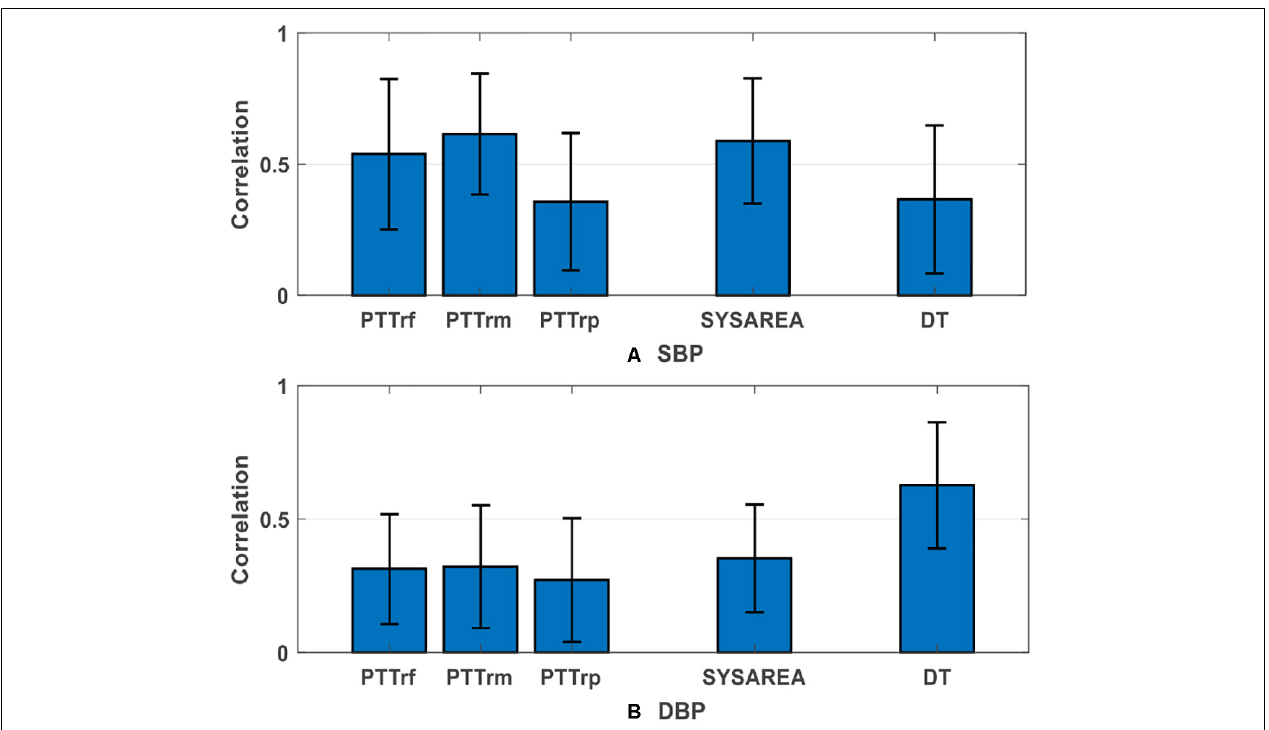
FIGURE 6 | Group average absolute correlations (mean value ± standard deviation) between three PTTs and the PPG features that most relevant to blood pressure versus (A) SBP and (B) DBP. DBP, diastolic blood pressure; SBP, systolic blood pressure; other abbreviations and detailed definitions show in Table 1